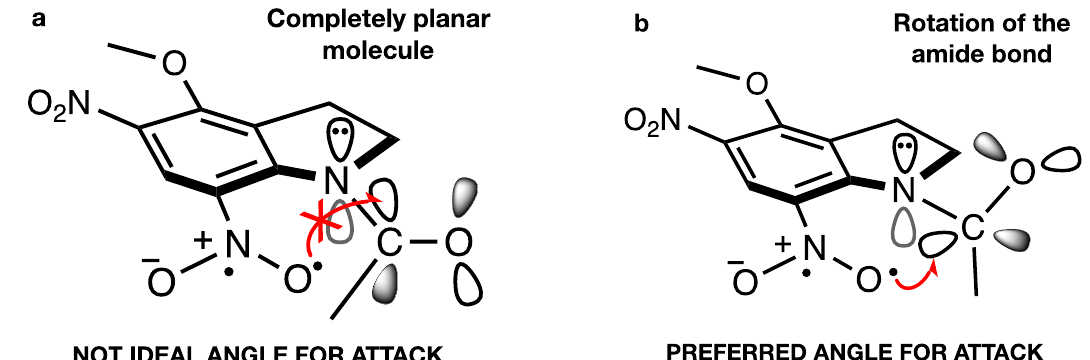
Figure 4. Key electronic effects for the cyclization and migration pathways (CP and MP). The oxygen radical in ( a ) is not positioned at the ideal Bürgi–Dunitz angle of 107° relative to the plane of the molecule, and it is far away from the unoccupied orbital of the carbonyl group. Both pathways necessitate deplanarization of the amide bond via a rotation ( b ) in either sense, leading to two enantiomers (only one shown; see section S2 of the Supplementary Information for more details) in the case of the CP, or directly to the following intermediate in the case of